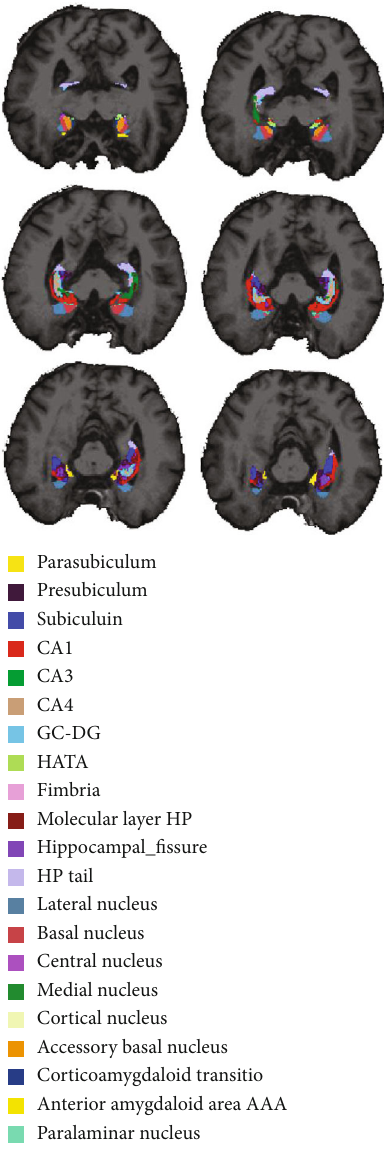
Figure 1: Segmentation template of the hippocampus and